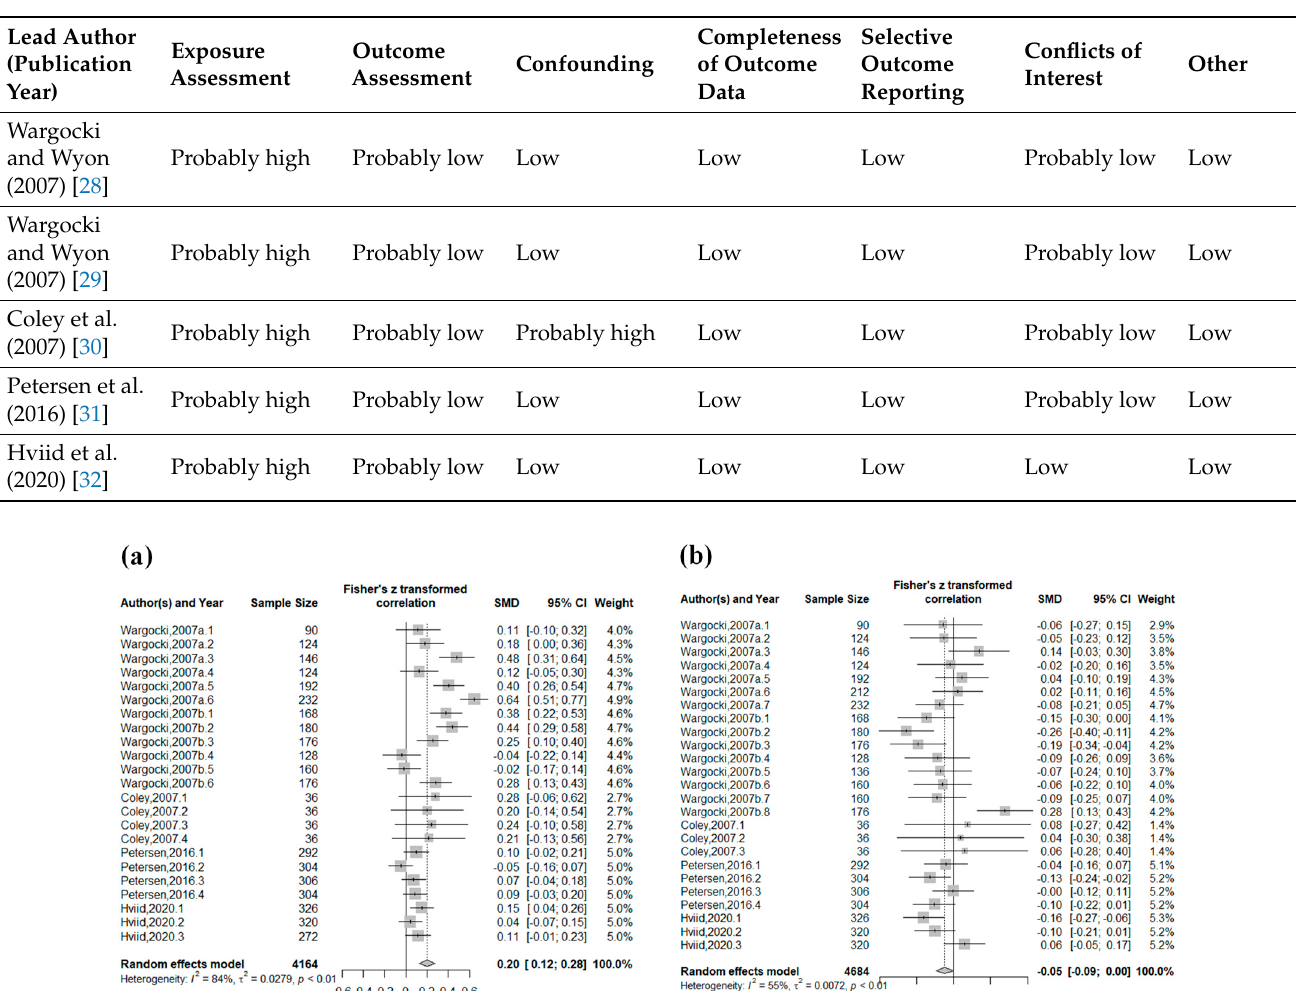
Table 2. Summary of risk of bias ratings. The assessment was based on Stieb et al. [24] criteria. Reasons for these risk of bias ratings for individual studies are noted in Supplemental Table S2.